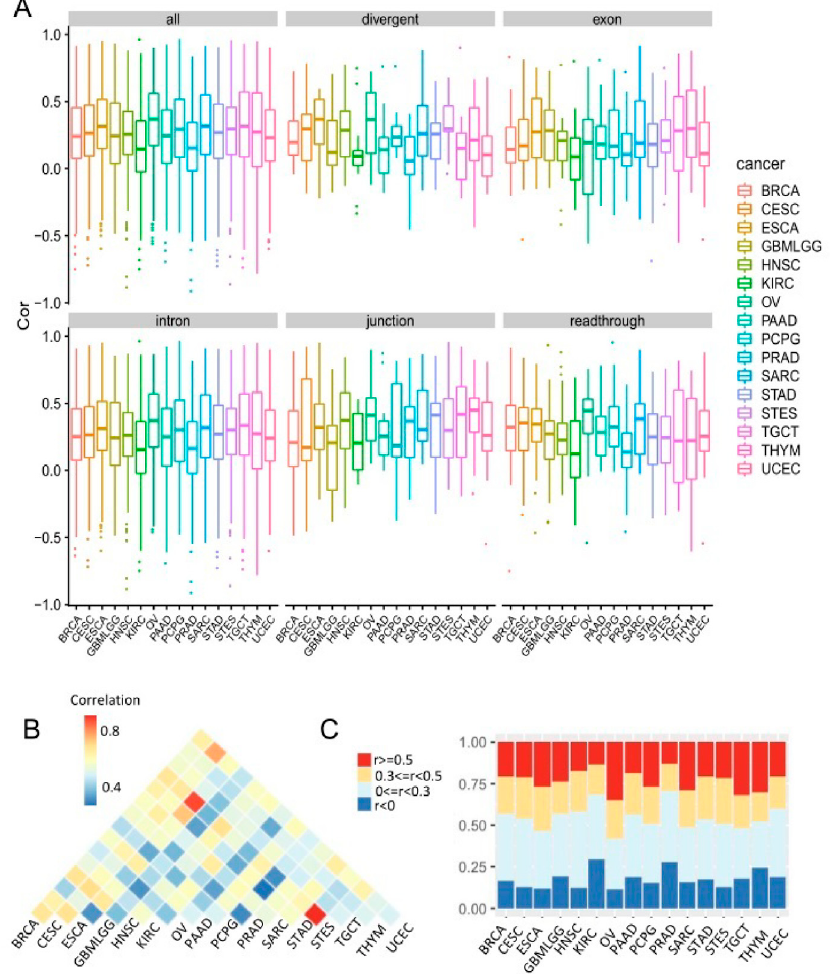
Figure 6. ( A ). Expression correlation between miRNAs and hosts across cancer types. ( B ) Correlation similarity between cancer types. ( C ). The distribution of expression correlation in each cancer type.